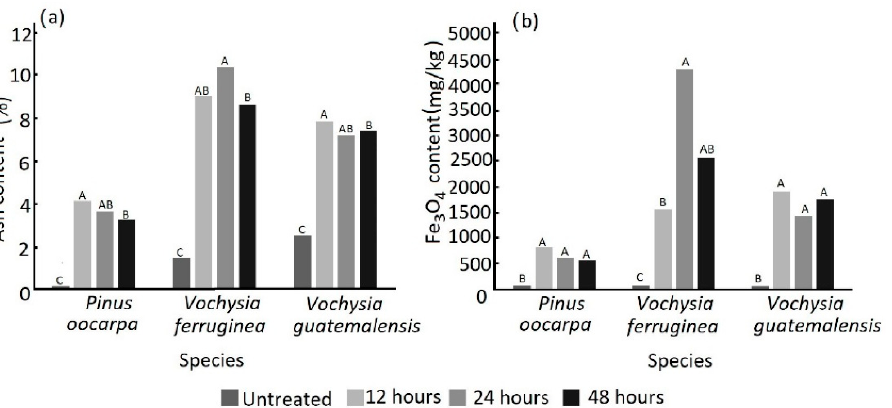
Figure 1. Ash ( a ) and Fe 3 O 4 NPs (nanoparticles) ( b ) content of untreated wood and magnetic wood with three different immersion times in ammonia in three tropical wood species from fast-growth plantations in Costa Rica. Note: Letters mean significant differences between treatment at 95% in each species.